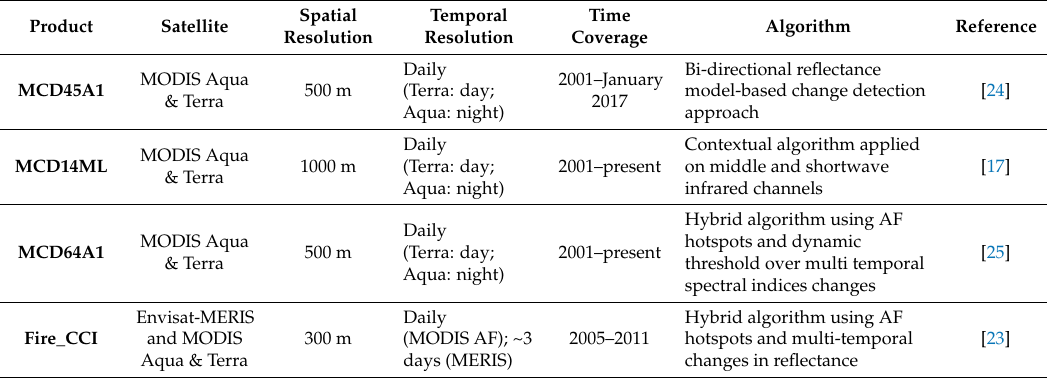
Table 1. Summary of the selected active fire (AF) and burned areas (BA)